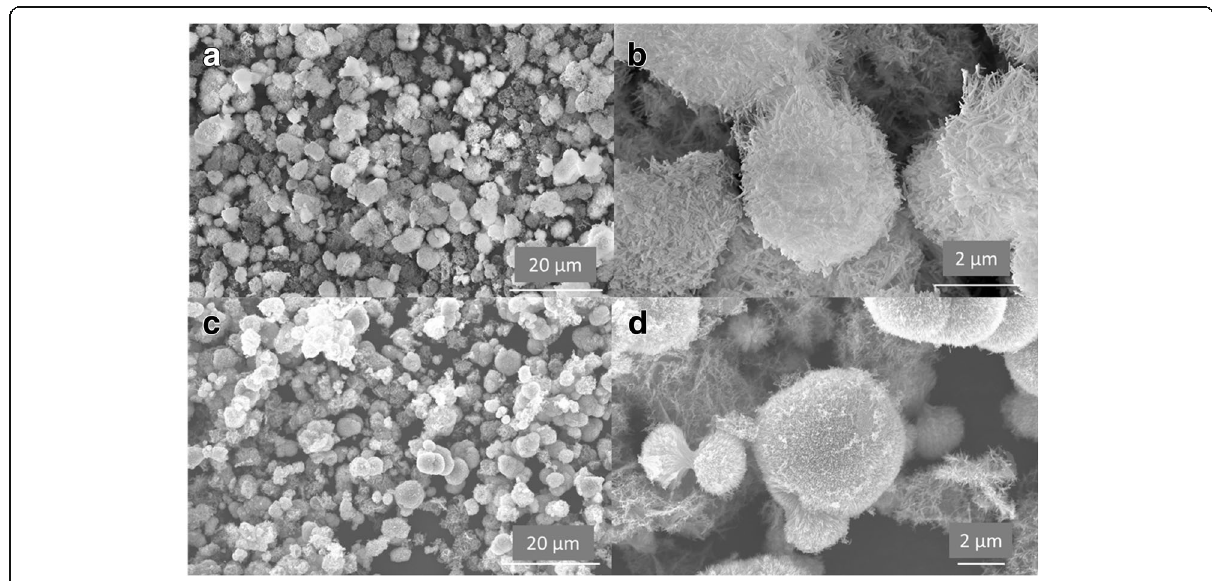
Fig. 3 Typical FE-SEM images of the as-prepared precursor synthesized with different amounts of PDDA solution a, b 2.5 g; c, d 10 g